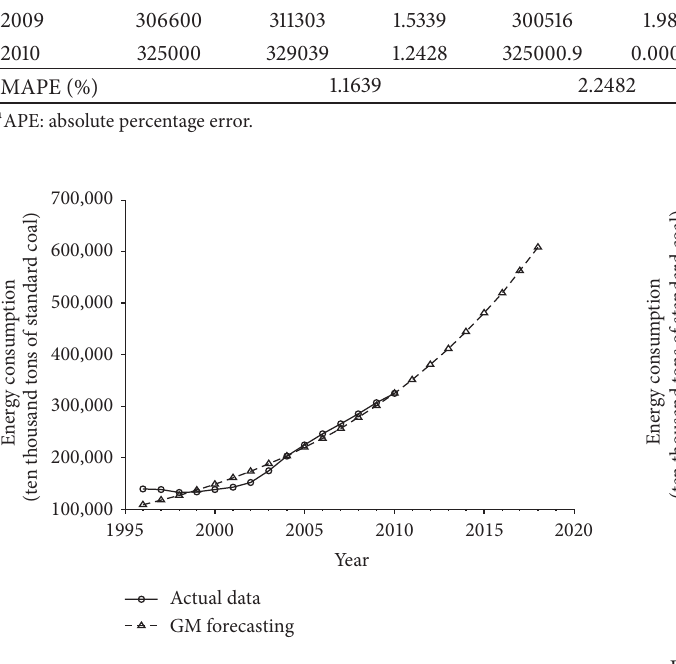
Figure 4: Forecast of China’s energy consumption by GM (1, 1).